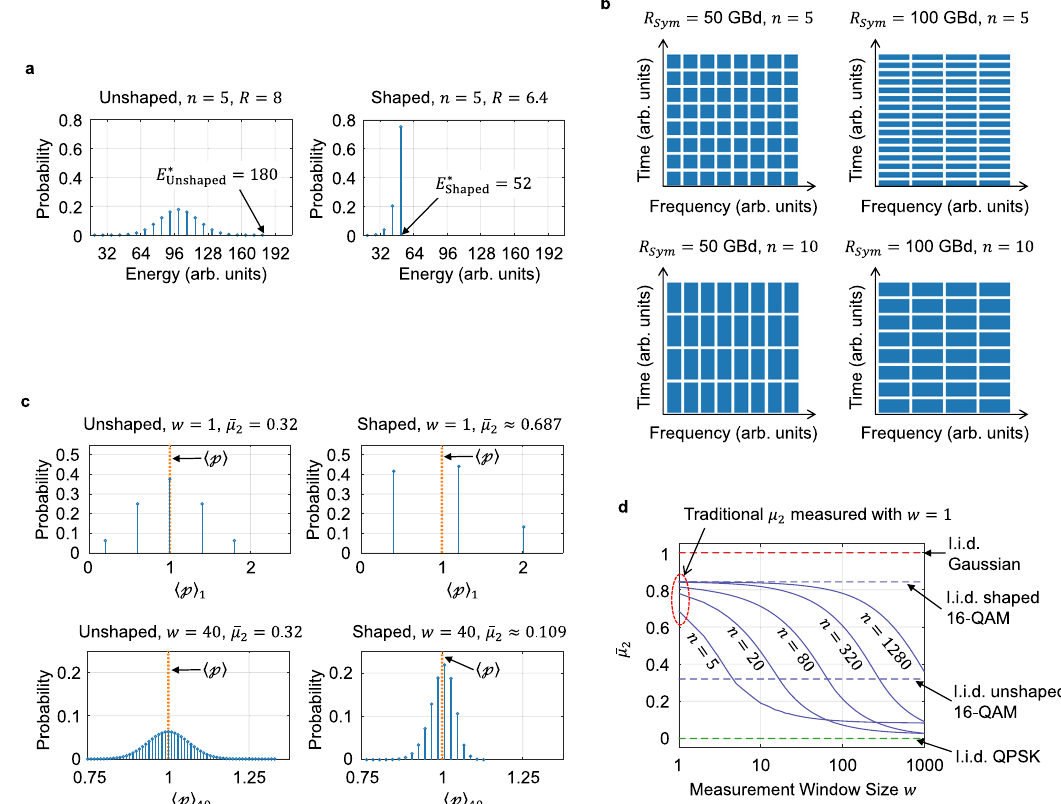
Fig. 1 Comparison of the power deviation between unshaped and shaped lightwaves. a Probability distribution of the total energy in a block of the unshaped (left fi gure) and shaped (right fi gure) symbols. The maximum energy is signi fi cantly lower in the shaped symbols than in the unshaped symbols. b Division of the continuum of lightwaves in time and frequency. The probability distributions shown in ( a ) appear in each of the rectangular blocks that (cid:7) (cid:8) fi gures) and shaped (right fi gures) symbols, measured divide the lightwaves. c Probability distribution of the normalized power p w of the unshaped (left with a sliding window of length w ¼ 1 (upper fi gures) and 40 (lower fi gures). d The windowed second central moment (cid:1) μ as a function of the measurement 2 window size w . As w increases, the moment decreases only for the shaped symbols. All shaped symbols in Fig. 1 achieve R ¼ 6 :